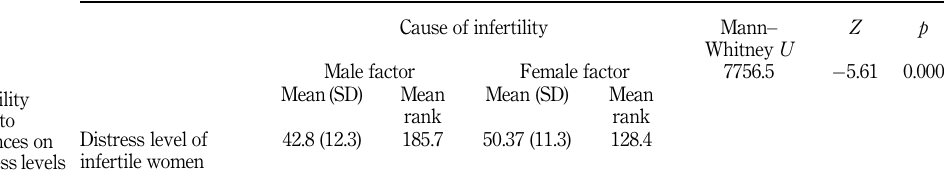
Table 2. Effect of infertility causes related to gender differences on women ’ s